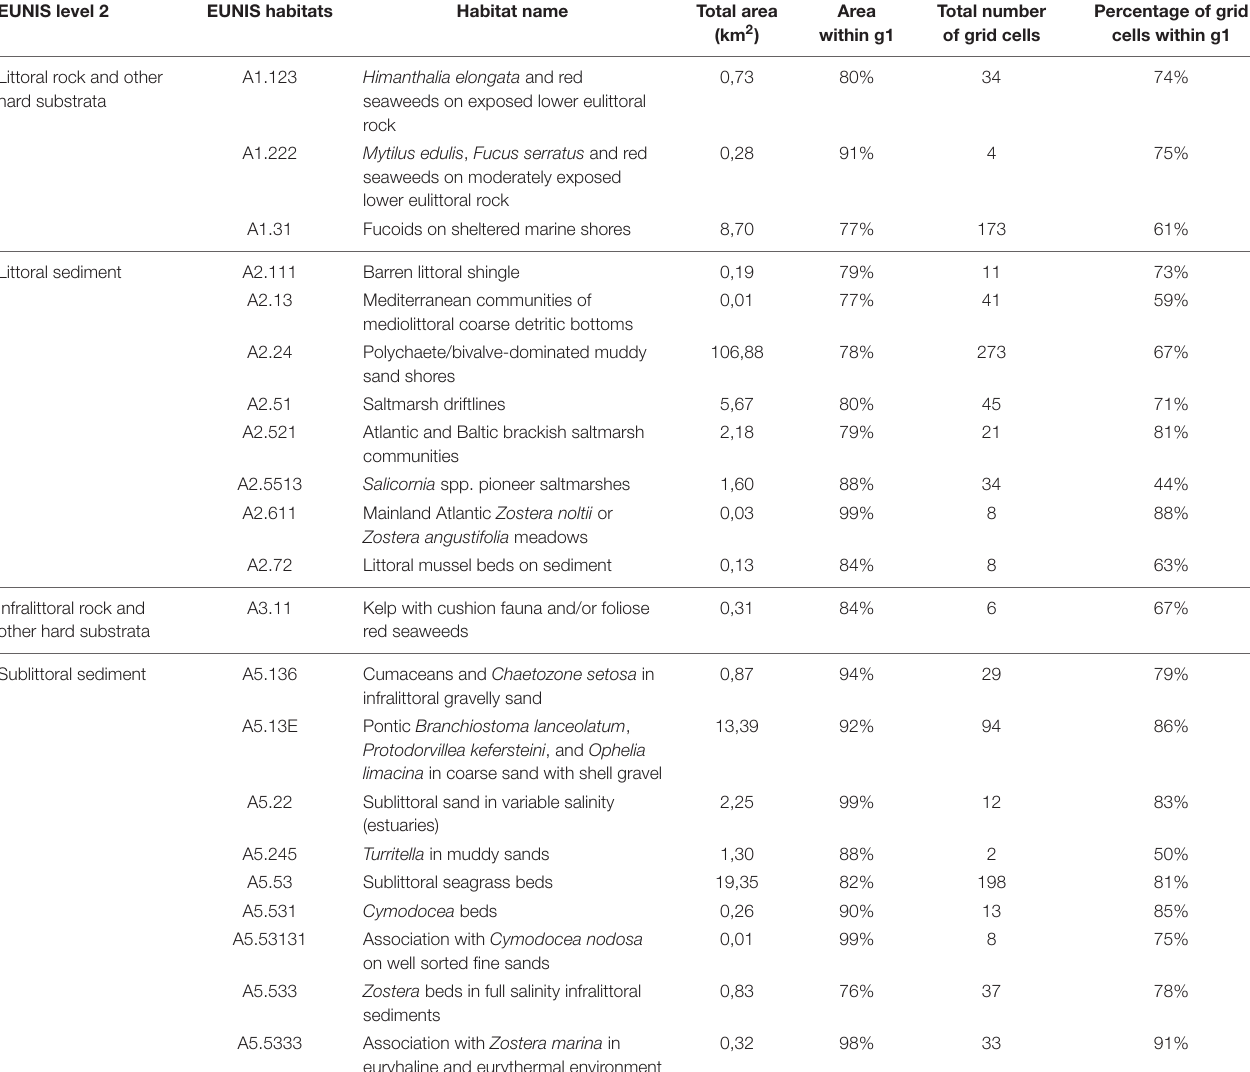
TABLE 5 | List of benthic habitats whose 75% of the total area is located in the grid cells of group g1. EUNIS level